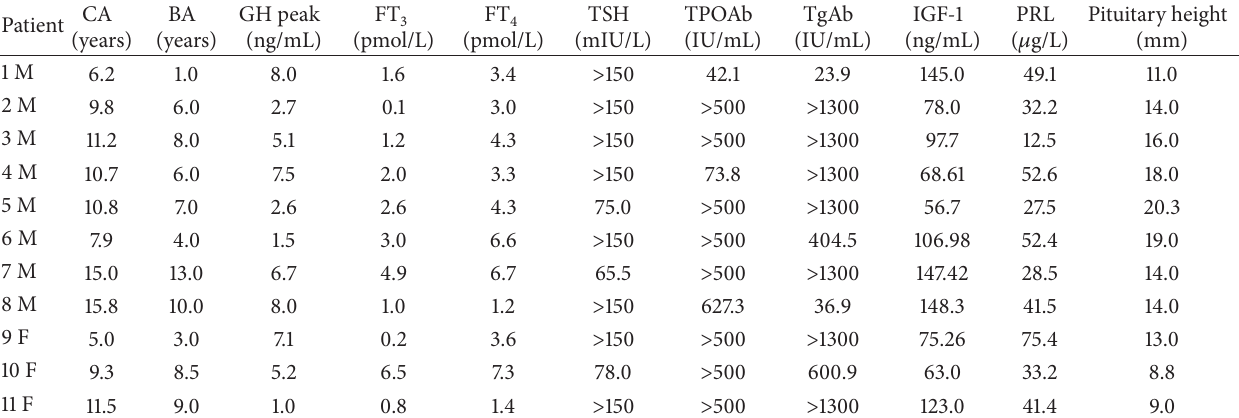
Table 1: Baseline characteristics of short-stature children with PPH accompanied by low GH levels.